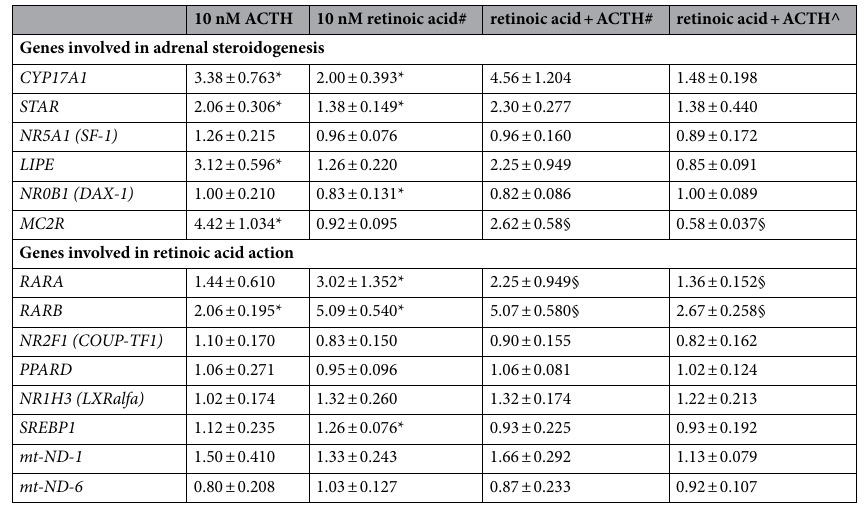
Table 1. Gene expression in adrenal cultures from patients with Cushing’s disease. # fold change relative to control wells; ^fold change relative to ACTH-stimulated wells; *p < 0.05 vs untreated wells; §p < 0.05 vs ACTH- treated wells. Data is expressed as mean ±